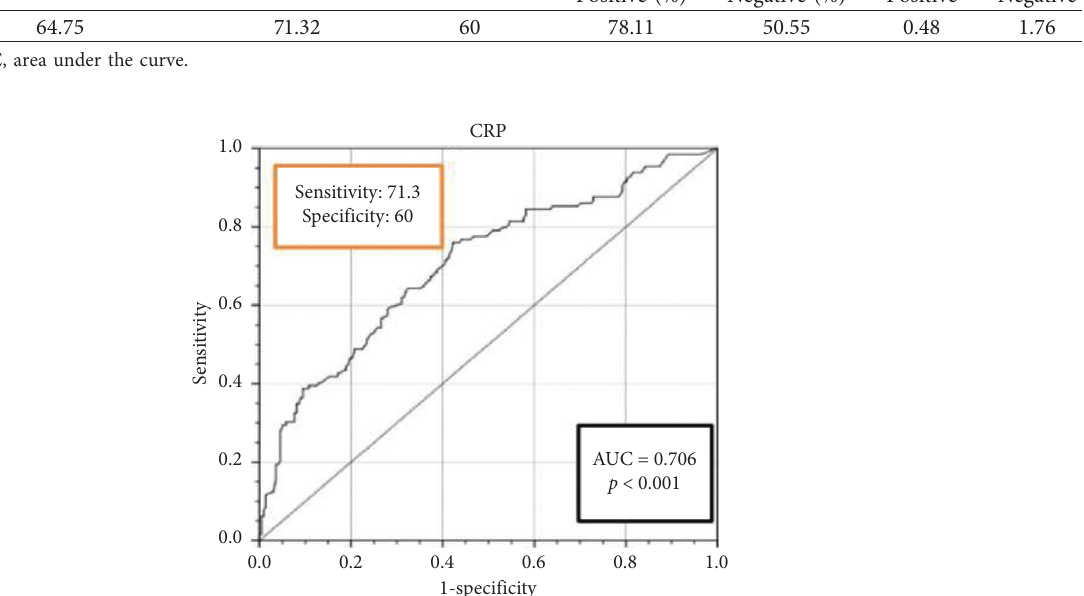
Figure 1: Receiver operating characteristic (ROC) curves of C-reactive protein for predicting the disease severity in COVID-19